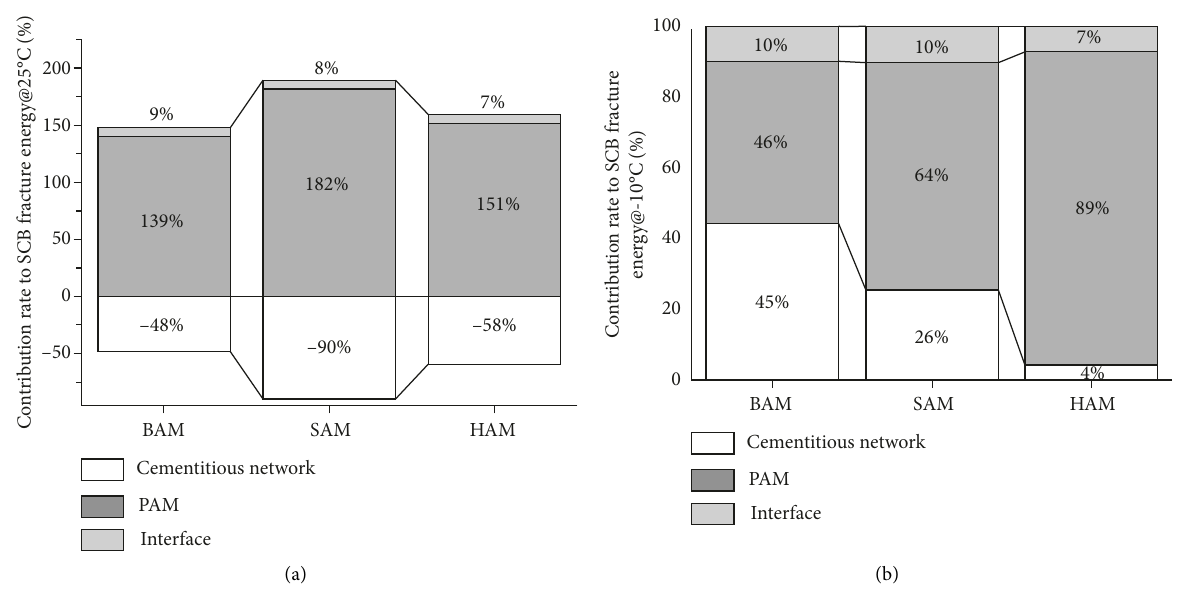
Figure 17: Contribution rates to SCB fracture energy. (a) 25 ° C. (b) − 10 ° C.